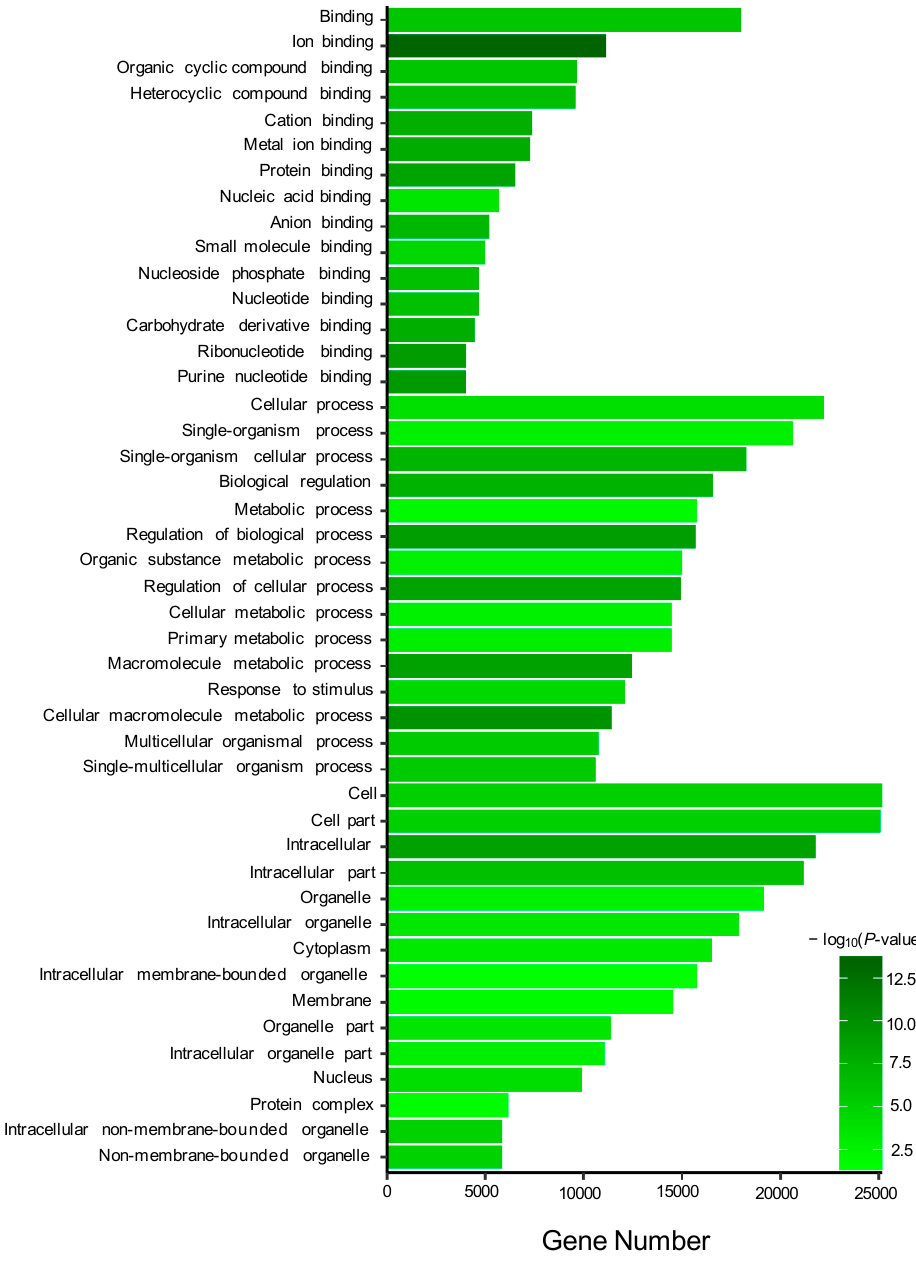
Figure 5. Gene ontology (GO) enrichment analysis of target genes of 195 novel DE miRNAs. KEGG enrichment analysis was performed for the target genes of DEMs, including known and novel DEMs. For the known DEMs, 138 target genes were assigned to 344 KEGG pathways. For the novel DEMs, 9824 target genes were assigned to 344 KEGG pathways. For the known DEMs, target genes were mostly concentrated in metabolic pathways, Rap1 signaling pathway, pathways in cancer, biosynthesis of secondary metabolites, biosynthesis of antibiotics, and other pathways (Figure 6A). For novel DEMs, target genes were mostly enriched in the mitogen-activated protein kinase (MAPK) signaling pathway, Human T-lymphotropicvirus 1 (HTLV-I) infection, oxytocin signaling pathway, axon guidance, microRNAs in cancer, and other pathways (Figure 6B).